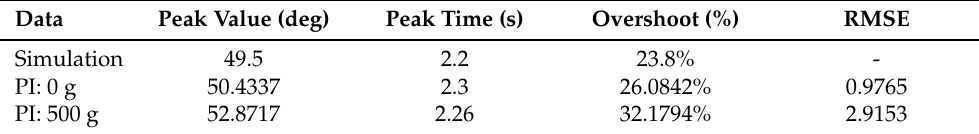
Figure 10. System response with the FOPI controller for a pitch step reference of α = 40 ◦ and a constant yaw angle of β = 0 ◦ . Control specifications: φ m = 60 ◦ and ω gc = 1.5 rad/s. Table 5. PI system response. Control specifications: φ m = 60 ◦ and ω gc = 1.5 rad/s.